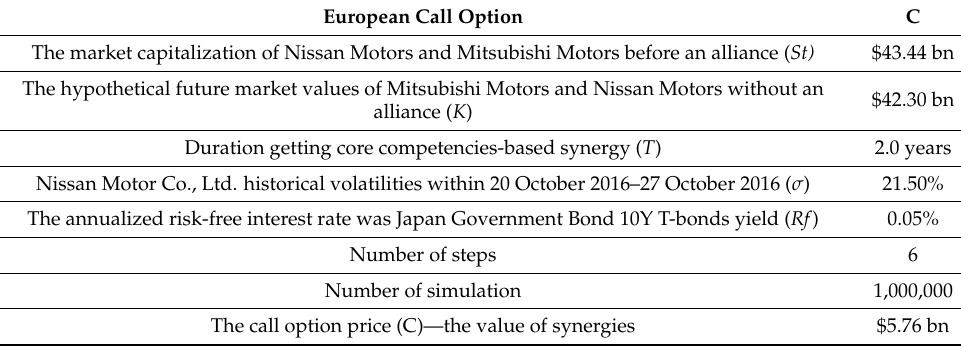
Table 4. Monte Carlo simulation real option variables and competence-based synergy’s